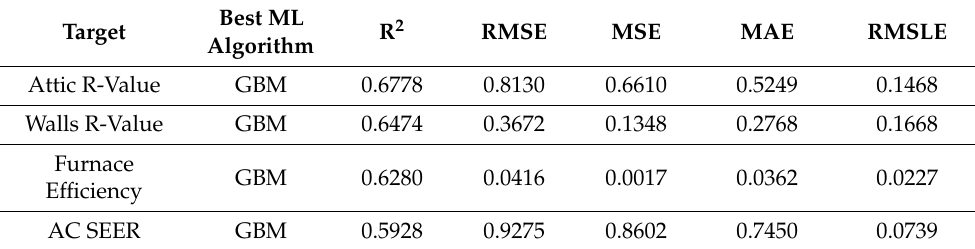
Table 14. Models’ prediction evaluation parameters for testing without using thermostat-derived